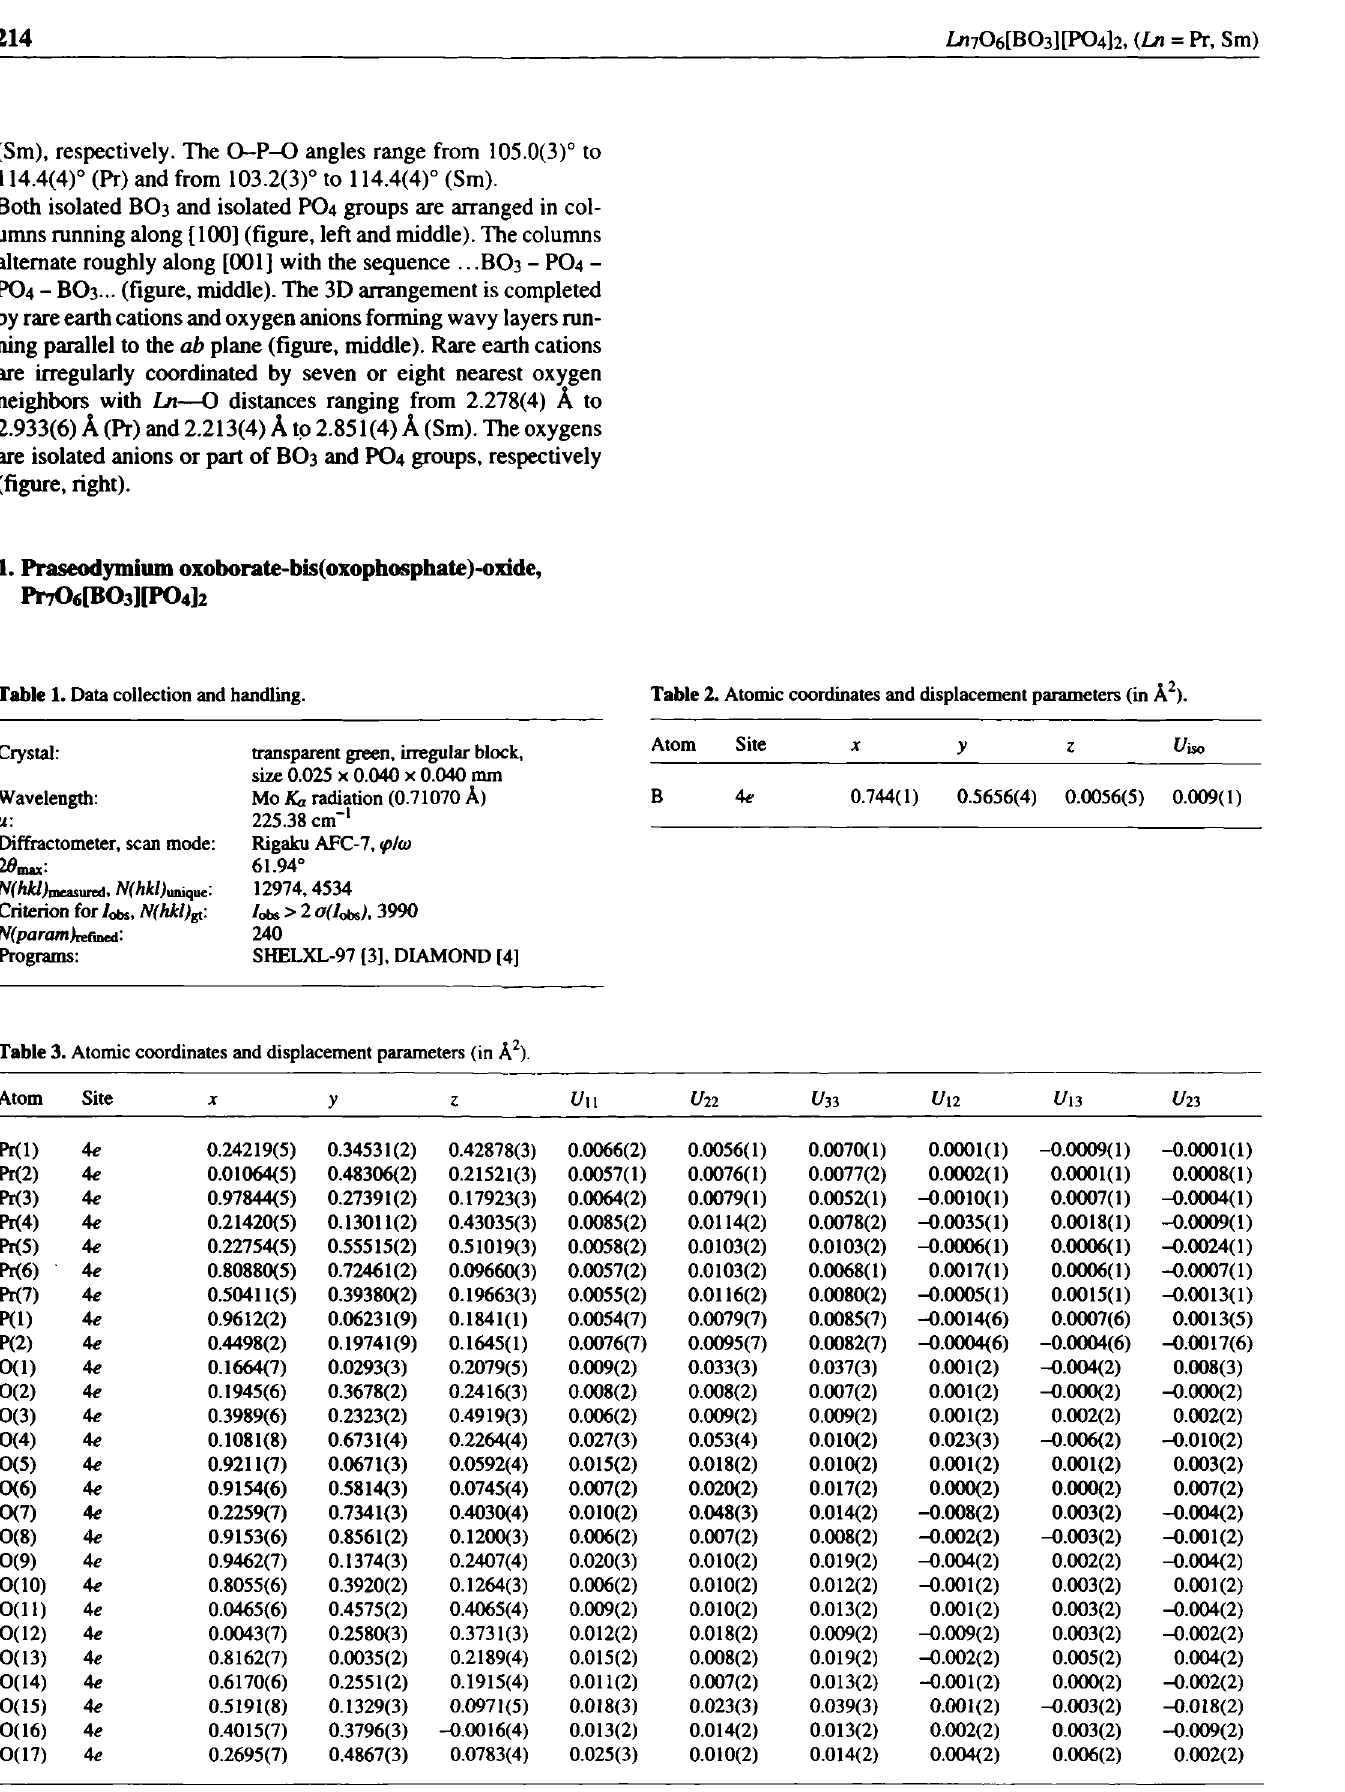
Table 3. Atomic coordinates and displacement parameters (in À 2